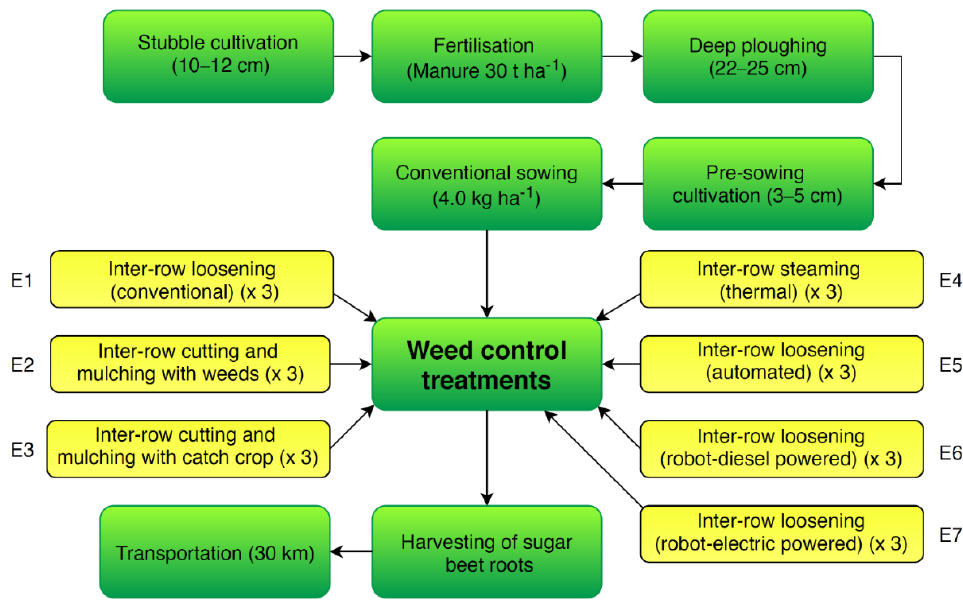
Figure 1. Scheme of weed control methods for comparative analysis. Note: (x3)—Technological operations were performed three times per season.